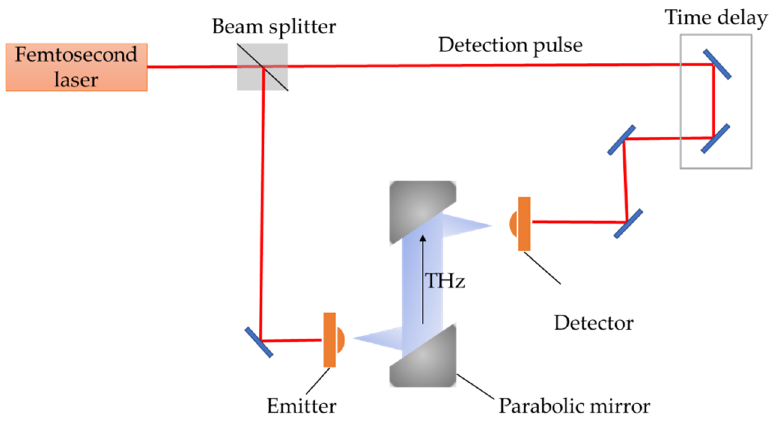
Figure 1. Schematic of a typical setup for generation and detection of THz pulses using femtosecond optical pulses.